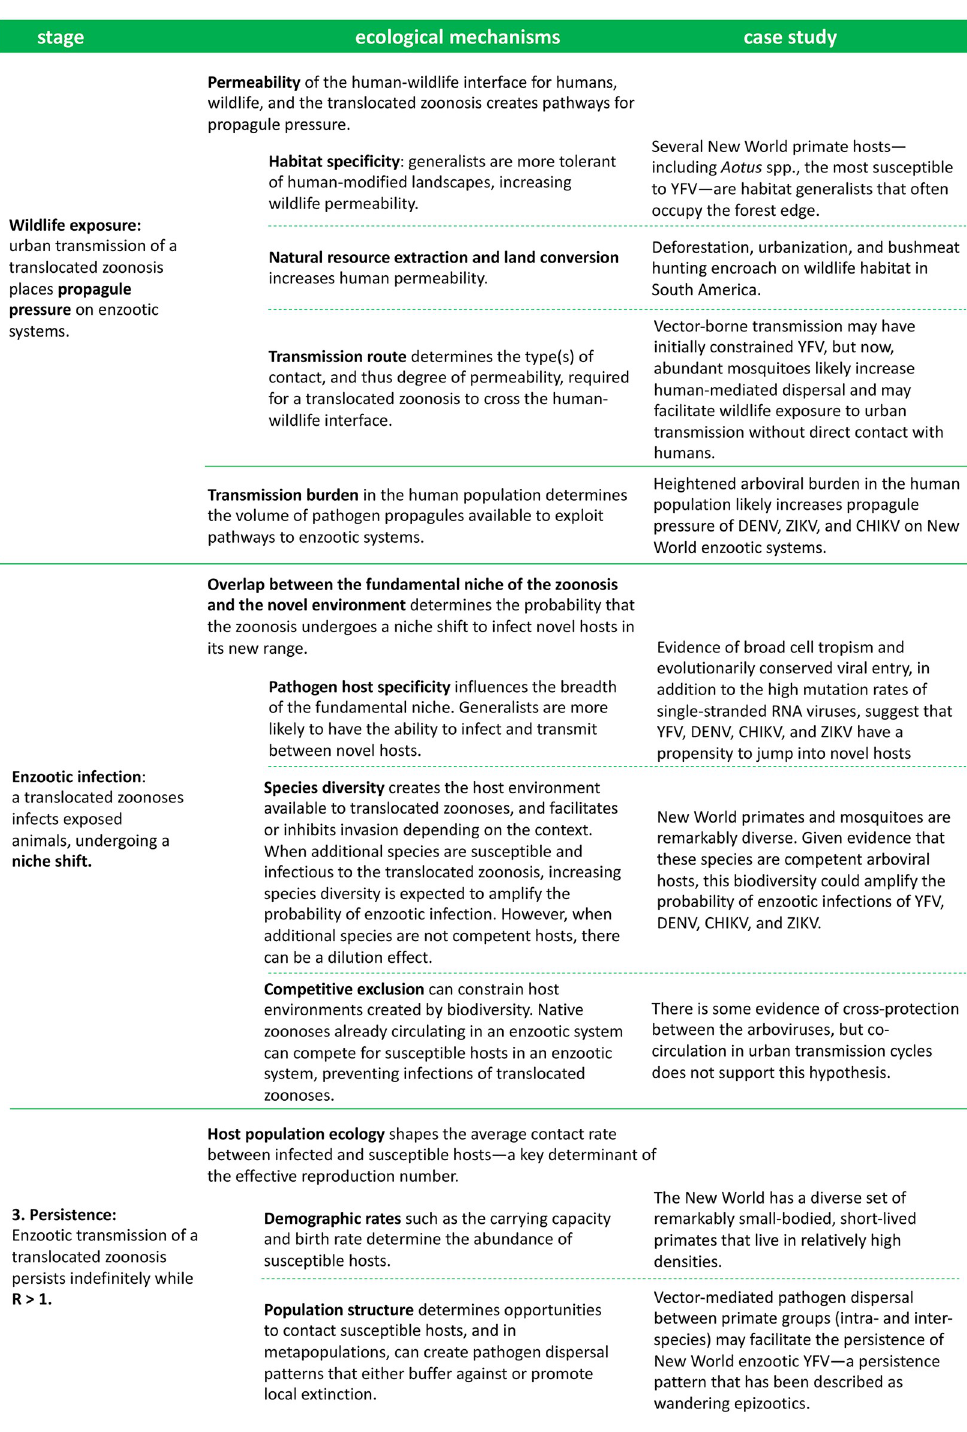
PLOS NeglectedTropical Diseases | https://doi.org/10.1371/journal.pntd.0008338 August 13,